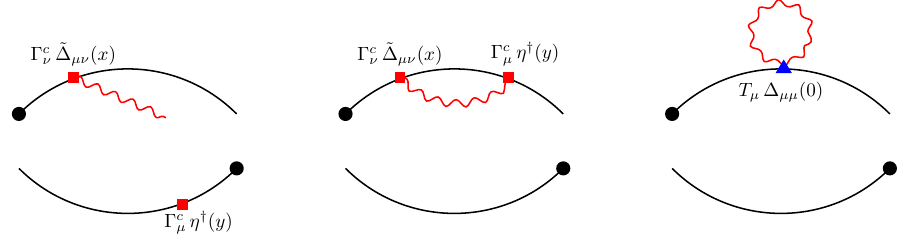
Figure 2 . Building blocks for the construction of the O ( (cid:11) ) QED correction diagrams for mesonic two-point function. From left to right: photon exchange diagram, quark self-energy diagram, tadpole